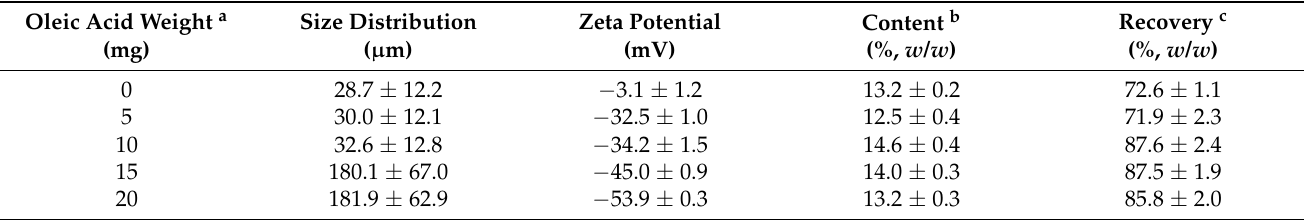
Table 2. Physicochemical properties of MLCs with the various weight ratios of oleic acid/stearic acid. Oleic Acid Weight